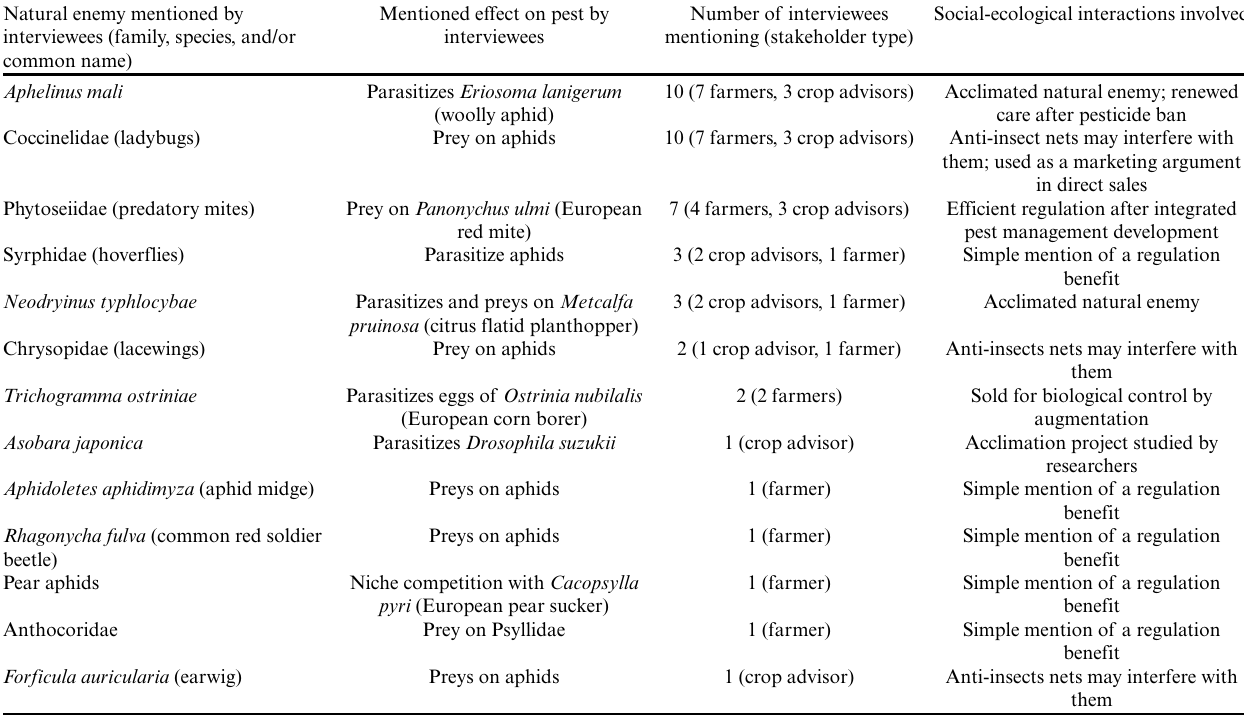
Table 1. Characteristics of natural enemies mentioned during individual interviews as resources involved in pest control. Natural enemy mentioned by interviewees (family, species,